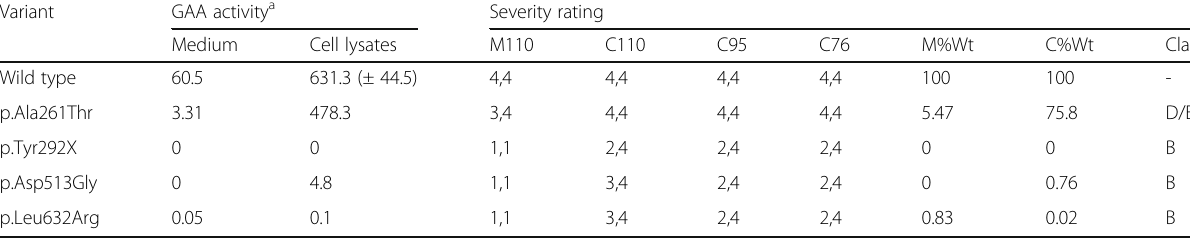
Table 4 Specific activity of GAA mutants in transiently transfected COS-7 cells and severity rating